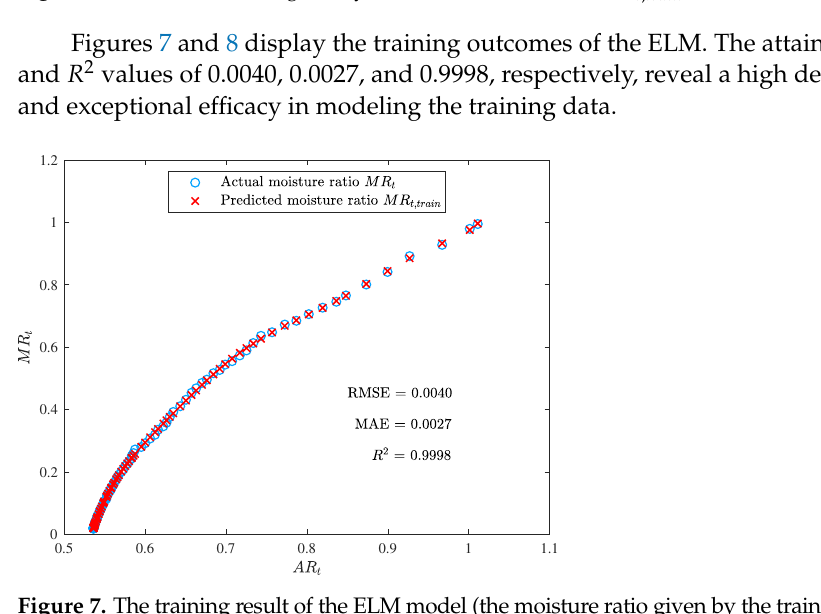
Figure 7. The training result of the ELM model (the moisture ratio given by the trained model MR t , train vs. the area ratio AR t ).